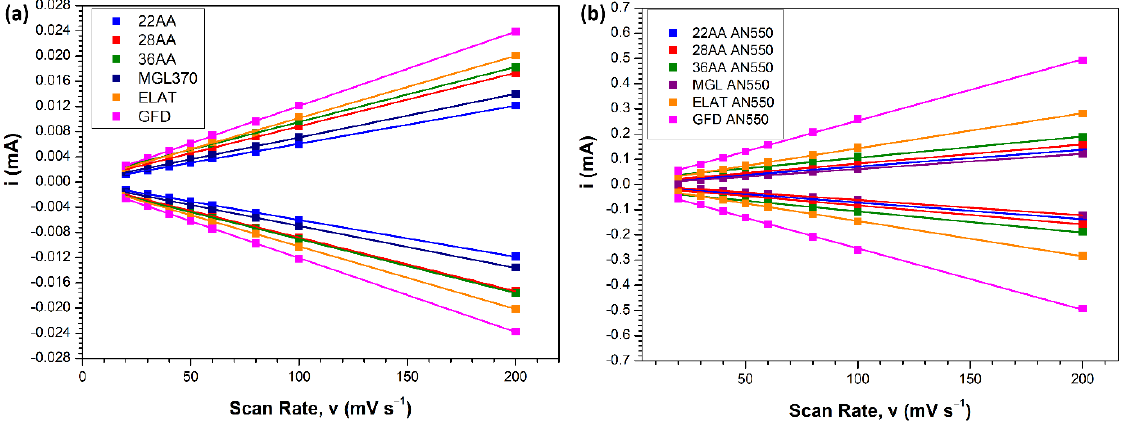
Figure 6. Plots of iC a and iC c vs. v on ( a ) as-received electrode materials ( b ) materials thermally oxidised at 550 °C for 5 h. 1 M KCl electrolyte. Working electrode area 0.1 cm 2 . Temperature 25 °C.